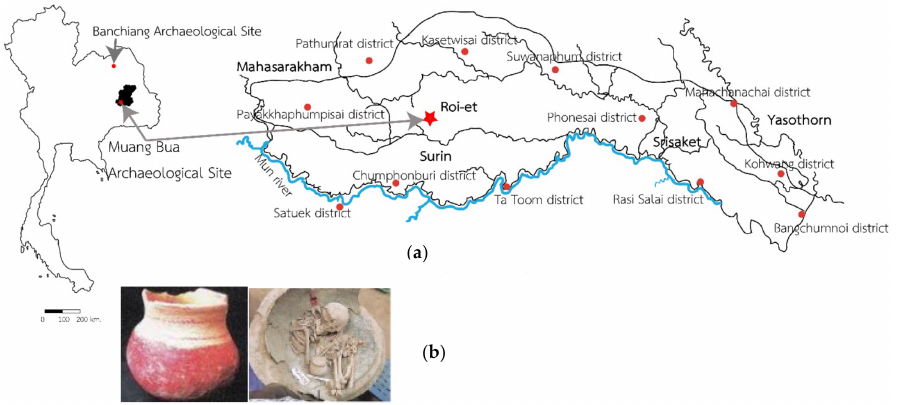
Figure 1. ( a ) Thung Kula Rong Hai area, and ( b) ancient burial pottery at Ban Muang Bua archaeo- logical site. Adapted with permission from ref. [24] (2010) (Fine Arts Department: Ubol Ratchathani, Thailand) and Nimsuwan, N.; Dutchaneephet, J.; Pakawanit, P.; Dararutana, P.; Won-in, K. (2019) (Malays. J. Microsc.)